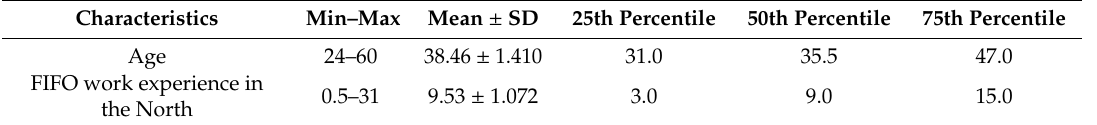
Table 1. Sample characteristics.